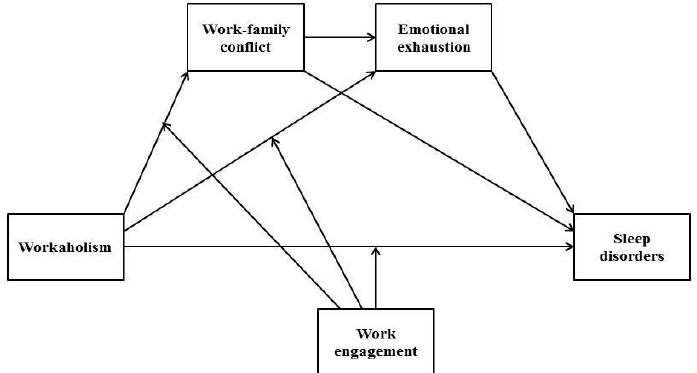
Figure 1. Mediation effect of work–family conflict and emotional exhaustion in the relationship between workaholism and sleep disorders, including interactions between workaholism and work engagement on work–family conflict, emotional exhaustion, and sleep disorders.